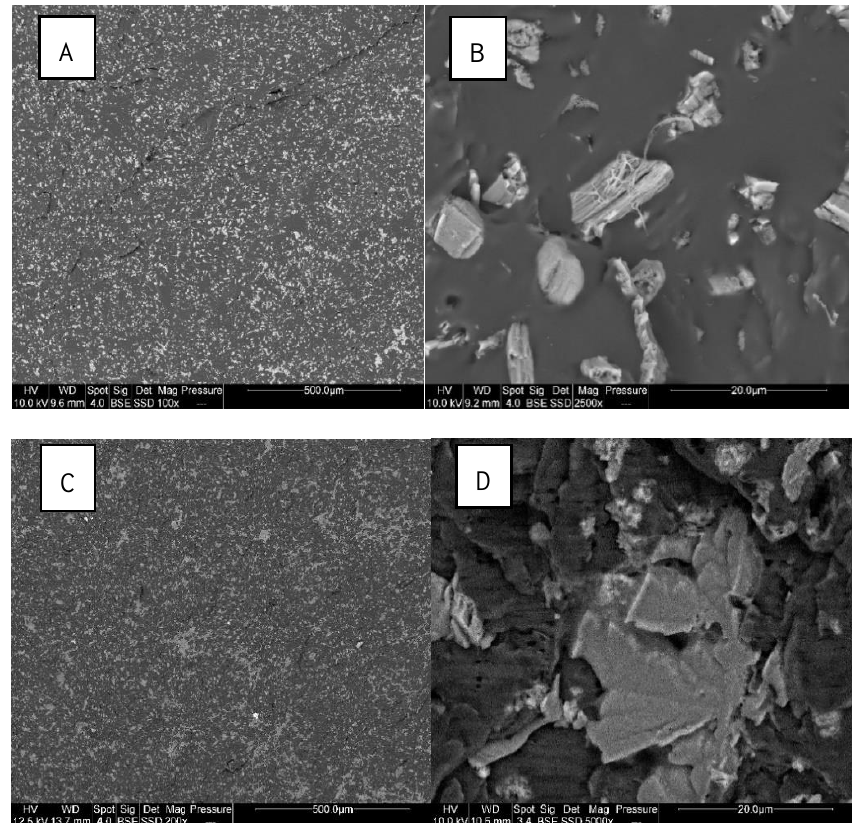
Figure 1. SEM pictures of ammonium polyphosphate (APP)-polyurethane elastomer (PUE) and APP- polylactide (PLA) composites (( A ) PUE1 ×100; ( B ) PUE1 ×2500; ( C ) PLA1 ×200; ( D ) PLA1 ×5000). Figure 2 and Figure S1 correspond to thermogravimetric and derivative curves of PUE0, PUE1, PLA0 and PLA1. For PUE, two dTG peaks are observed with a main peak at 421 tends to reduce the thermal stability of this polymer. Observing results of TGA in Table 2, T ON-SET of ◦ PUE1 is 45 C lower than PUE0. T max has been also strongly shifted to lower temperatures. However, maximal loss rate is similar between PUE0 and